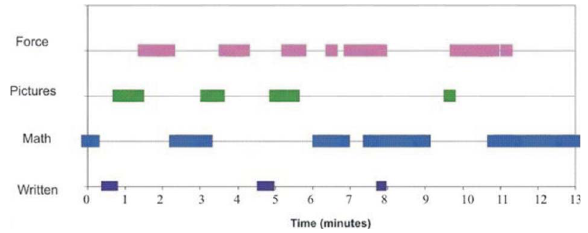
FIG. 6. (cid:1) Color online (cid:2) Graph of a 202 novice’s representation use during their solution of the electrostatics challenge